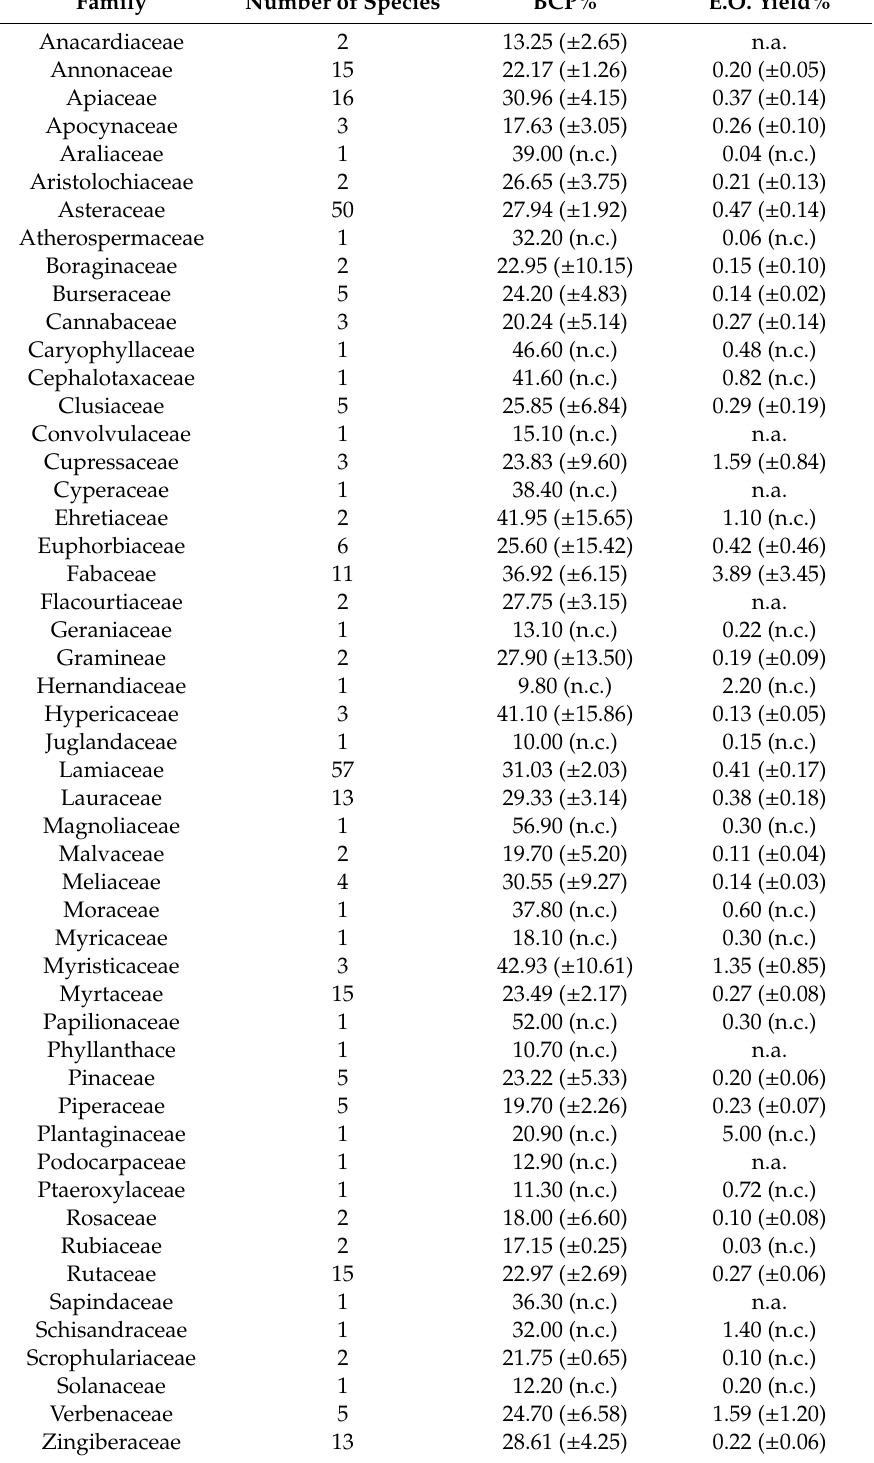
Table 4. Average percentages of BCP and yields from plant families belonging to the plant species reported in Table 1. ( ± S.E.M.); n.c., not computable; n.a., not available; E.O., essential